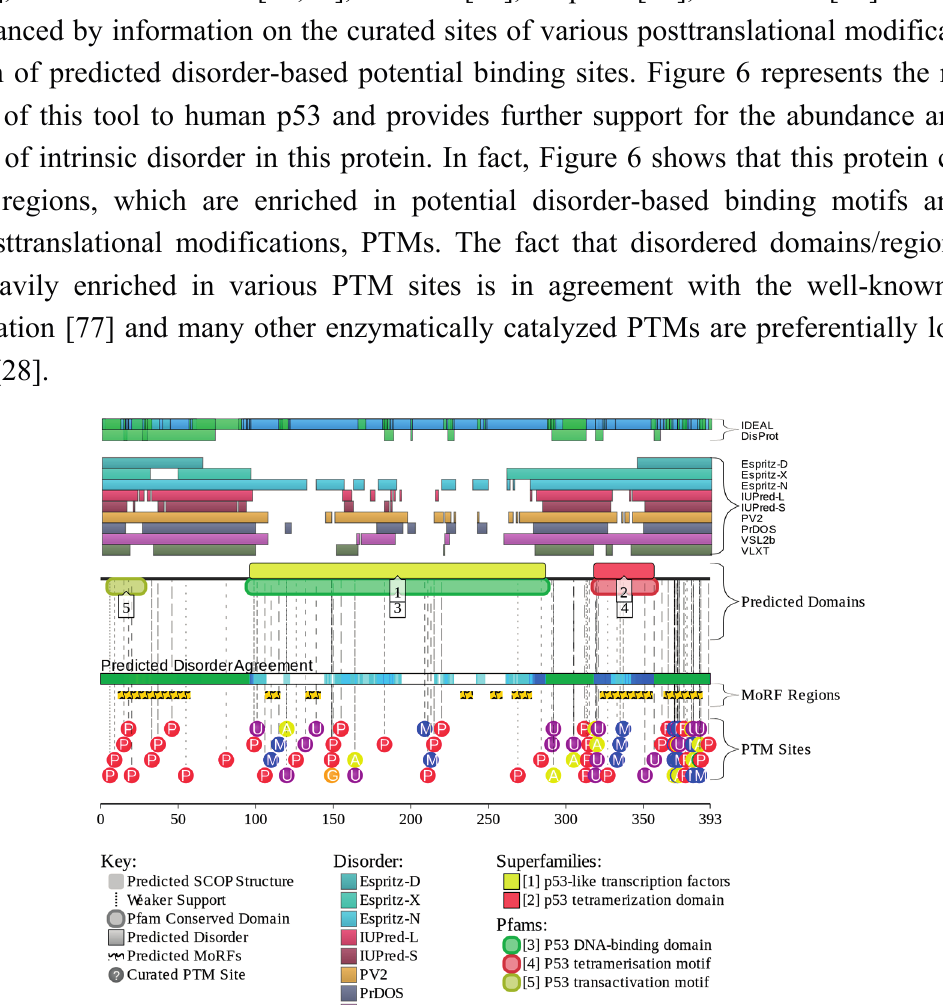
Espritz-N, Espritz-X, IUPred-L, IUPred-S, PV2, PrDOS, PONDR ® VSL2b, and PONDR ®